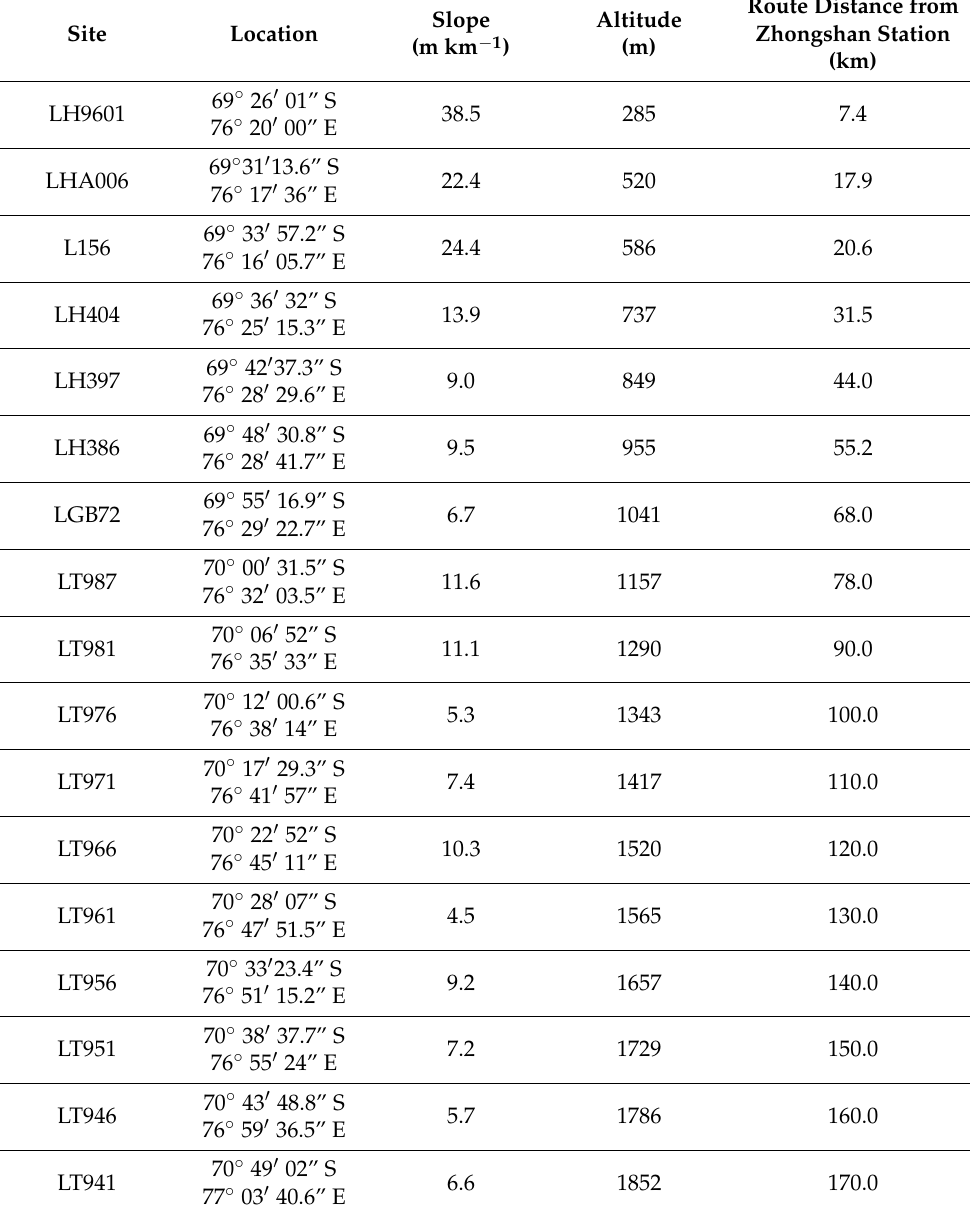
Table 1. Geographical information of the surface snow samples.